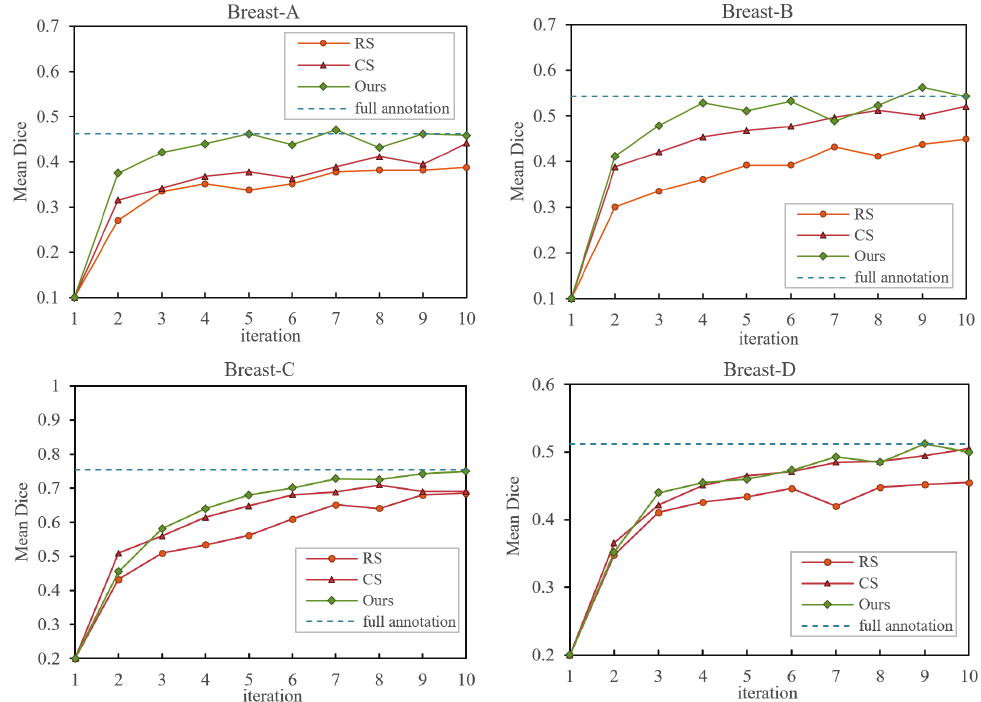
Figure 5. Plots of mean Dice coefficients, comparing different sampling strategies. It’s noted that RS and CS refer to random selecting sampling and CoreSet sampling [34],